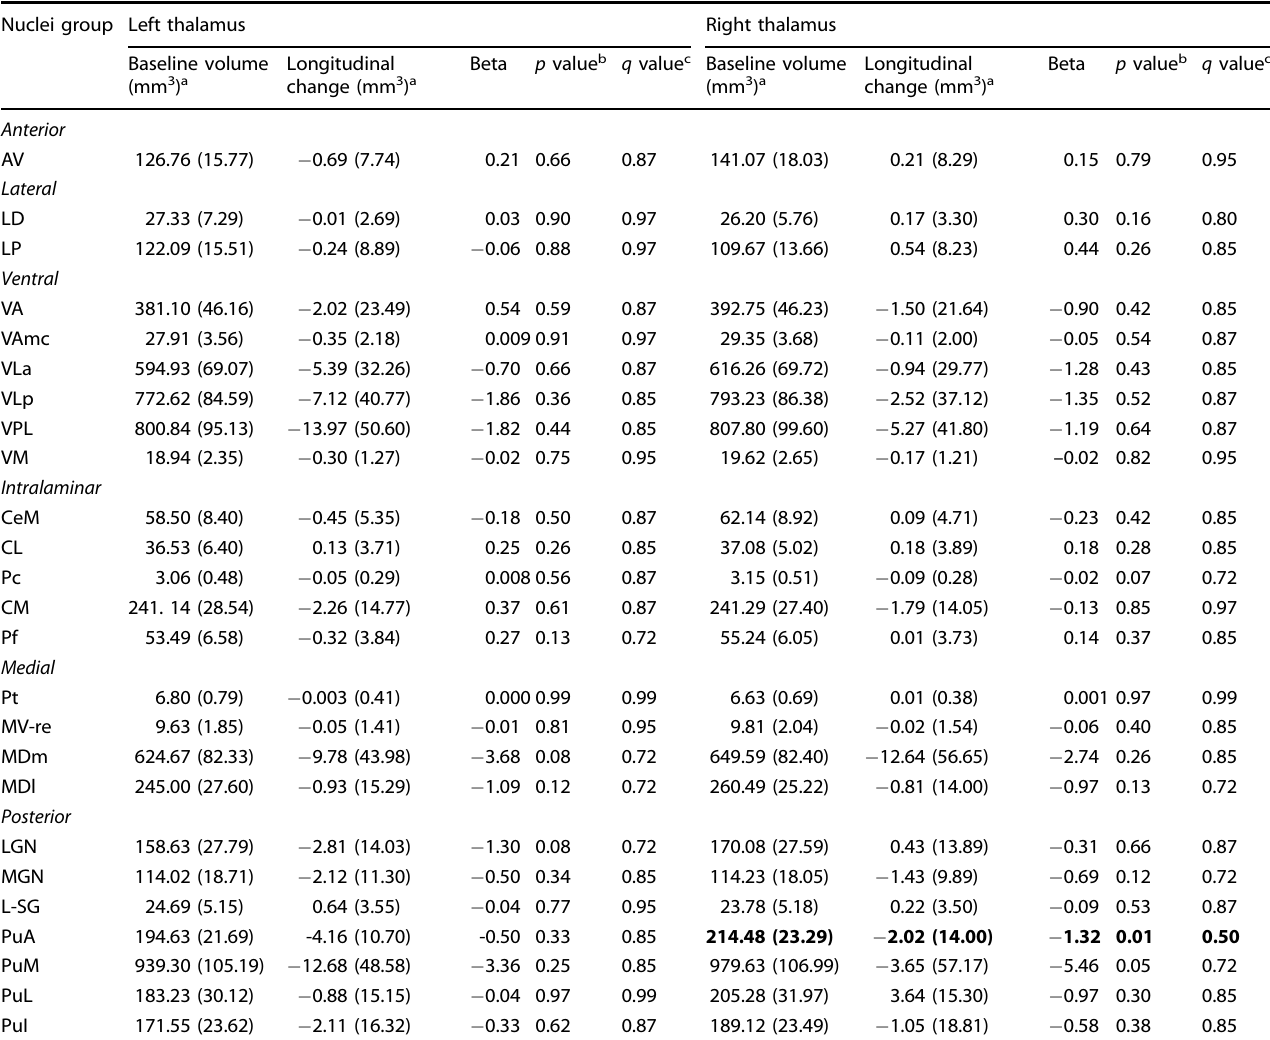
Table 3. Association of HADS depression score with thalamic subnuclei